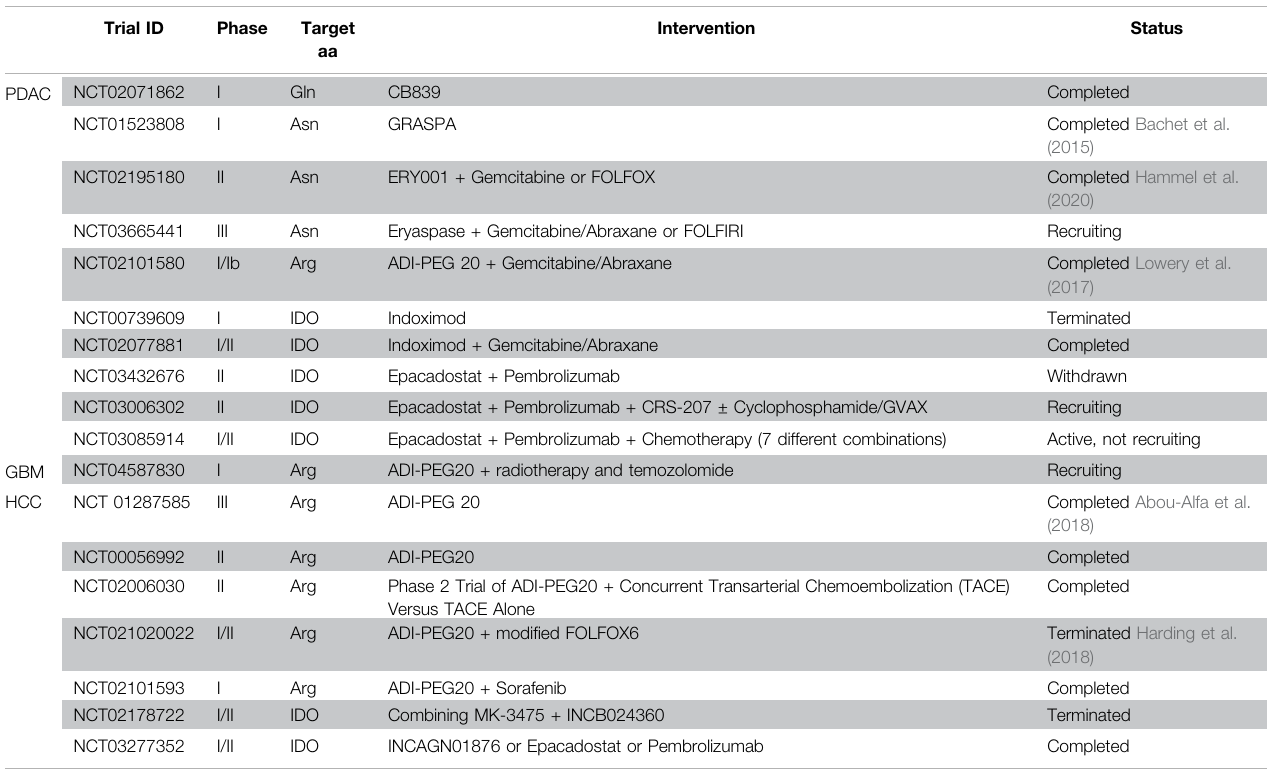
TABLE 1 | Clinical trials targeting amino